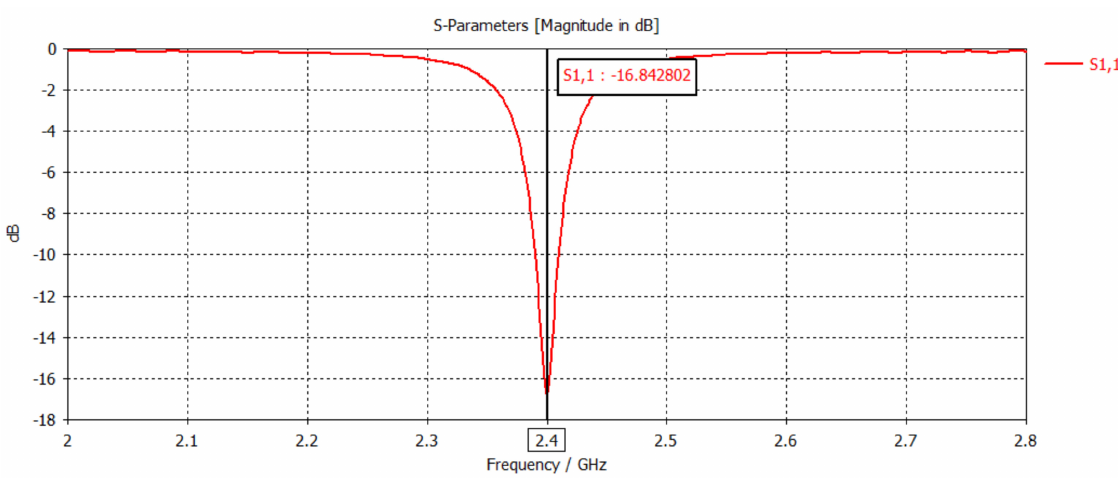
Figure 15. S11 parameter by frequency in new design of patch antenna of 2.4 GHz with line transmission λ /4.